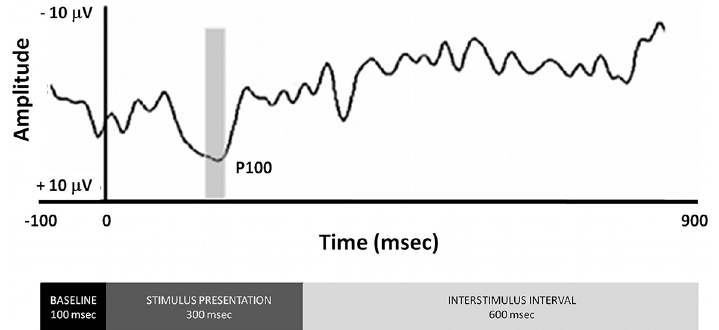
Fig 2. Event Related Potentials Following presentation of tactile presentation of spatial information. Time frame to analyze the P100 component was 80 – 220 ms and it was determined by searching for the maximal amplitude in the respective time window at the Pz electrode. The BMA analysis was made opening a time window of -20 to +20 ms starting from the high amplitude pick measured in Pz electrode. The bottom of the figure displays the time blocks of the experimental